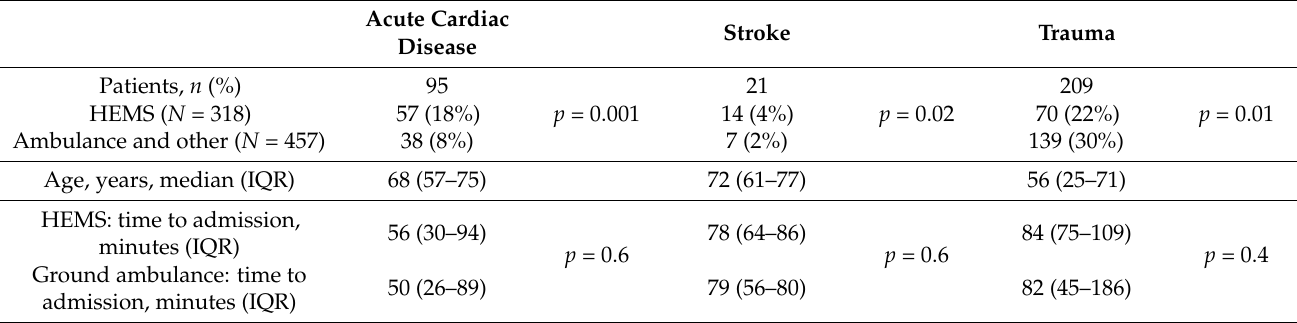
Table 2. Characteristics for patients admitted to hospital with acute cardiac disease, stroke, and trauma diagnoses. Acute Cardiac